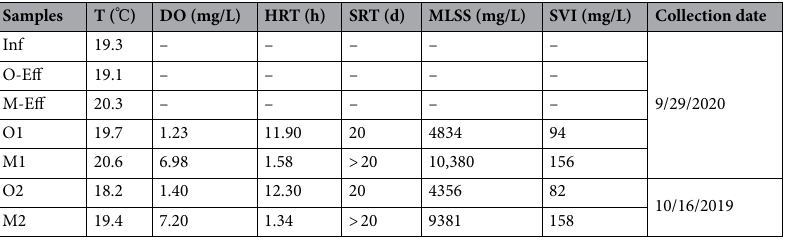
Table 2. Sample information